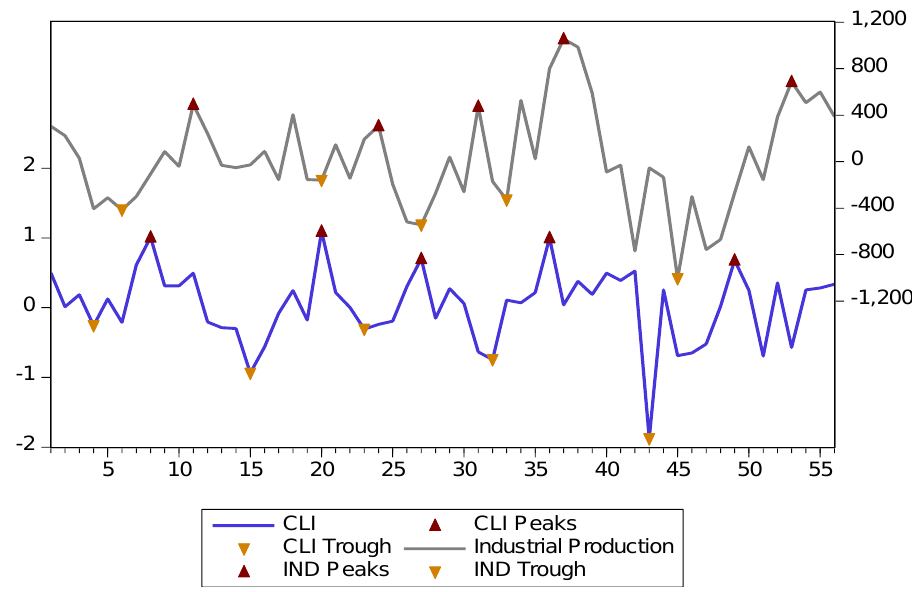
Figure 7. Comparing the turning points of equal weighting CLI with reference series